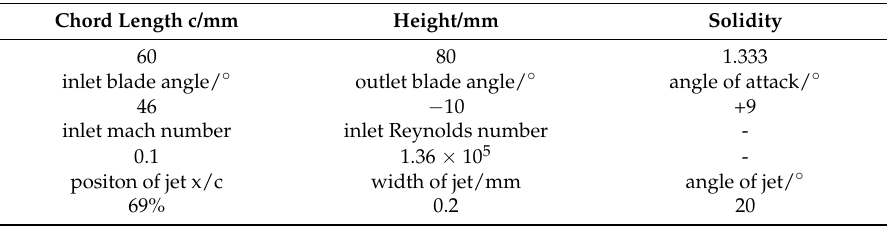
Table 1. Main parameters of the adopted cascasde.